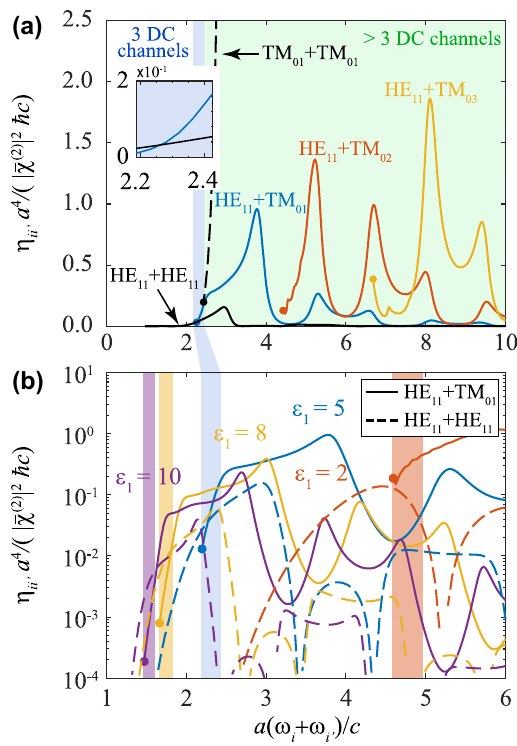
Figure 2: Down-conversion efficiency for different output channels. (a) Normalized SPDC efficiency for a waveguide with 𝜖 𝜖 = 1 as a function of incident light frequency 𝜔 = 𝜔 h Different output channels i + i ′ are indicated by labels, while the regions highlighted in white, blue, and green indicate 1, 3, and > 3 available channels (each of them degenerate in the sign of both the wave vectors and the azimuthal numbers). (b) Efficiencies corresponding to the three lowest channels (one in HE + TM ) for different values of the waveguide permittivity two in HE 11 01 𝜖 (see color-coded labels). Colored areas highlight the respective 1 regions in which three channels exist, while the frequency threshold for each of the down-conversion channels is indicated by colored